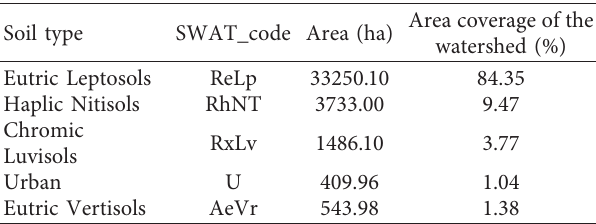
Table 3: Spatial distribution of soil types within the